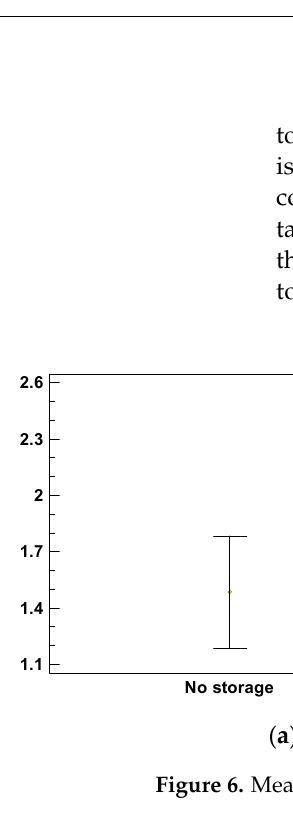
Figure 5. Classes of SD values of the loads measured in the two sampling seasons.